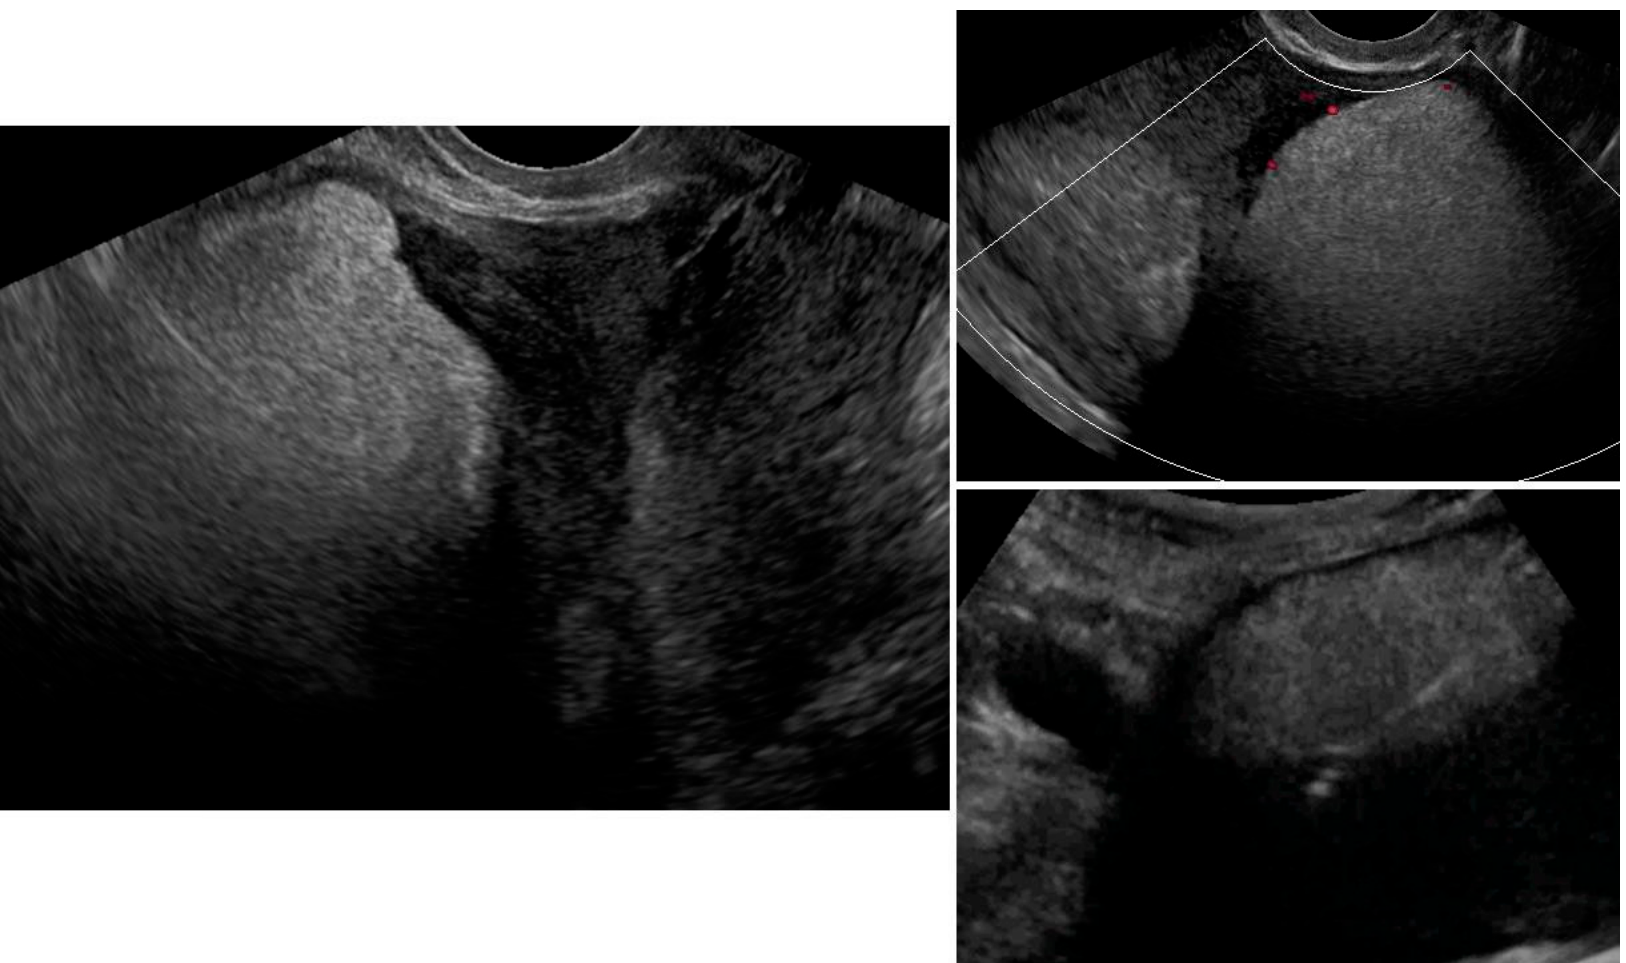
Figure A3. Transvaginal ultrasonogram of the uterine lesion (atypical) in the anterior myometrium, B mode and Doppler. Lower right figure presents transabdominal ultrasonogram of the UG-TUC core needle biopsy of the lesion. Histology: lipoleiomyoma.